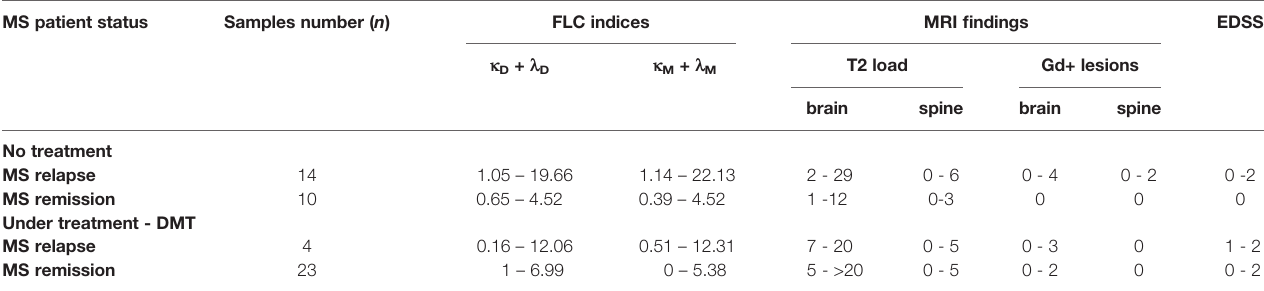
TABLE 1 | POMS patients: saliva FLC indices and clinical and radiological fi ndings.